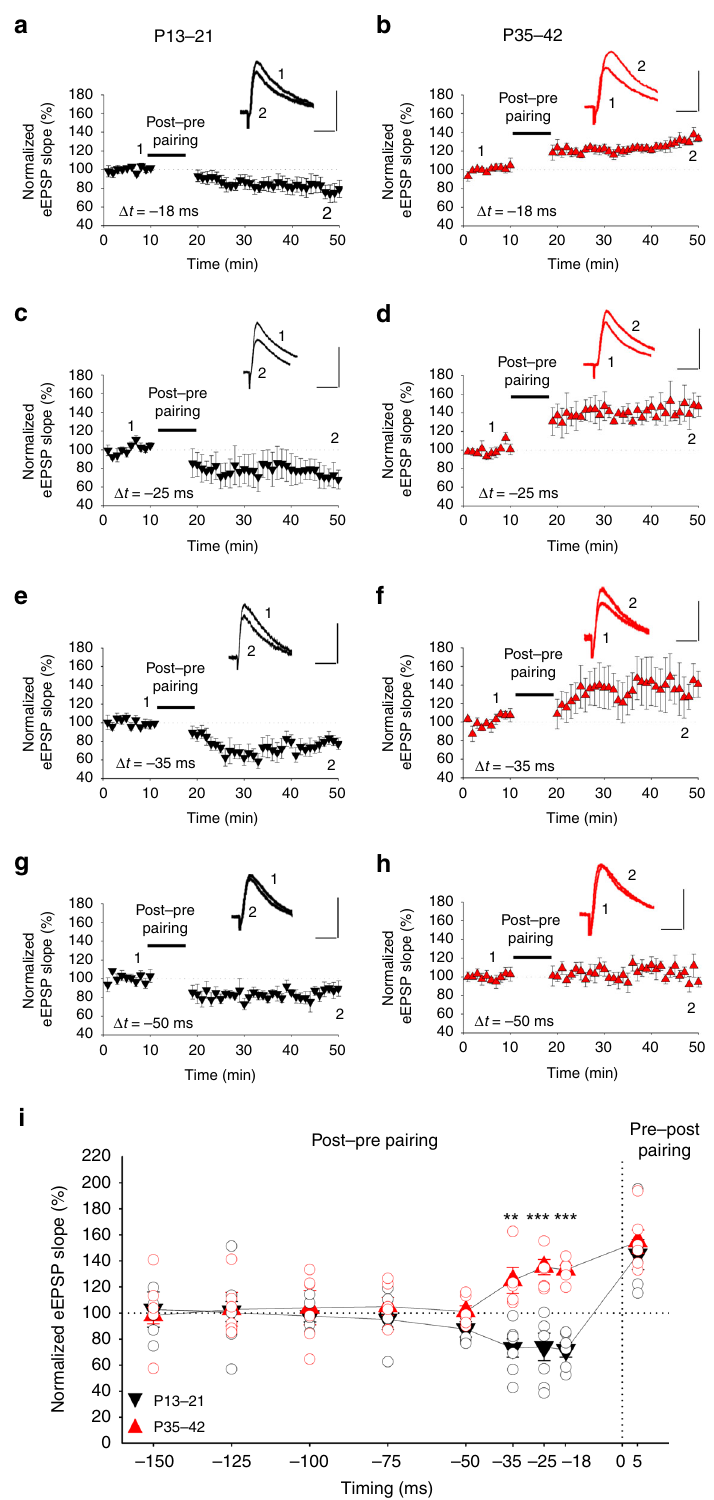
Fig. 2 Time window for STDP at P13 – 21 and P35 – 42. A post ‐ before ‐ pre pairing protocol at P13 – 21 (black) induces t ‐ LTD for Δ t = − 18 ms ( n = 6) a , − 25 ms ( n = 6) c and − 35 ms ( n = 7) e but not for − 50 ms ( n = 6) or a more negative Δ t. g At P35 – 42 (red), the same protocol induces t-LTP for Δ t = − 18 ms ( n = 6) b , − 25 ms ( n = 6) d and − 35 ms ( n = 5) f but not for − 50 ms ( n = 6) or a more negative Δ t. h Δ t: time interval between EPSP onset and peak of postsynaptic spike. The EPSP slopes monitored before and after the pairing protocol are shown. Traces show eEPSPs before (1) and 30 min after (2) the pairing protocol. Scale bars: 5 mV, 50 ms. i Summary plot showing the time window for STDP at P13 – 21 (black triangles) and P35 – 42 (red triangles). ** p < 0.01; *** p < 0.001, two-sided Student ’ s t test. The error bars represent the S.E.M. Source data are provided as a Source Data fi